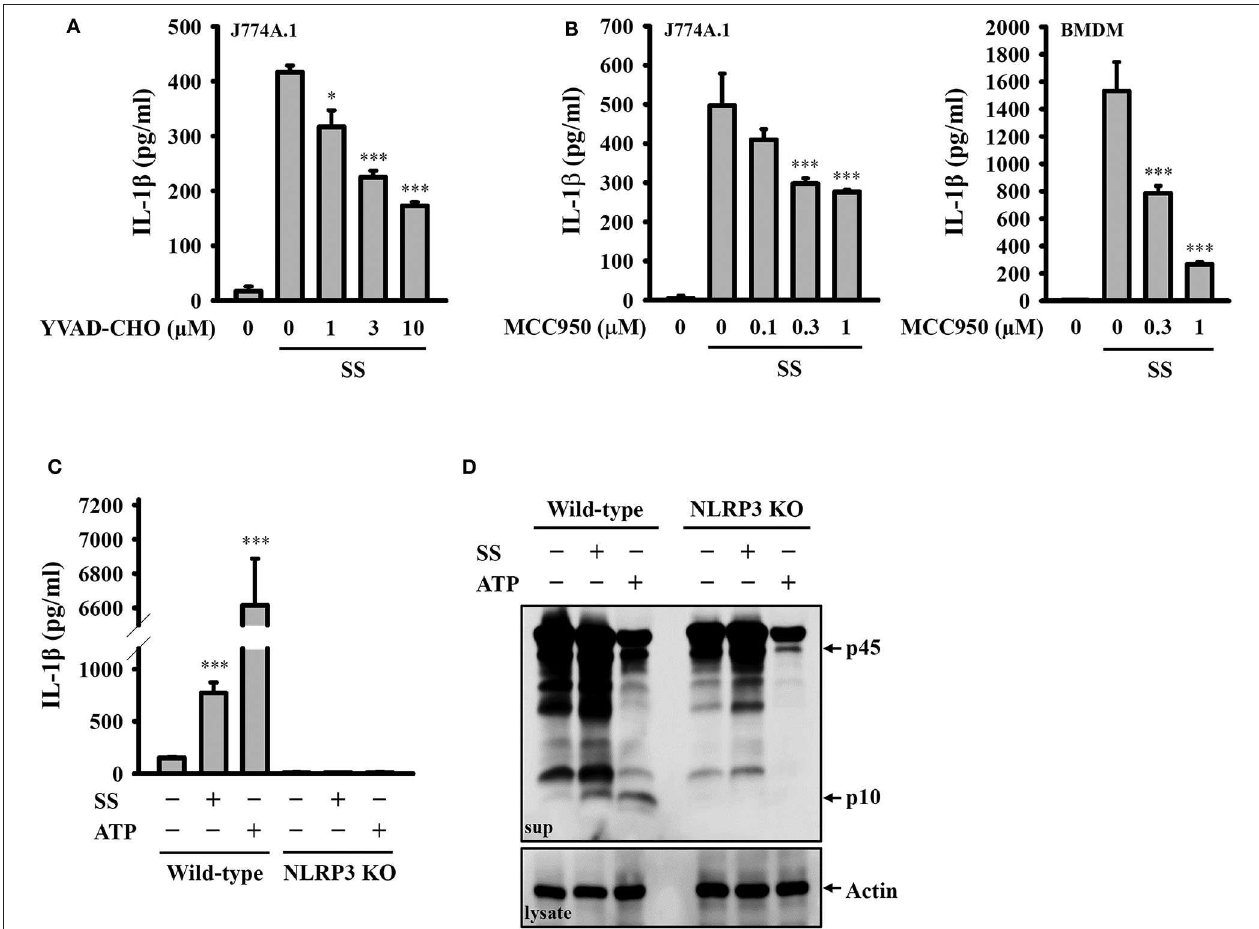
FIGURE 2 | S. sonnei induces IL-1 β secretion through the NLRP3 inflammasome. (A,B) J774A.1 macrophages or BMDM were primed with 1 µ g/ml LPS for 4h and then treated with YVAD-CHO (A) or MCC950 (B) for 0.5h. The cells were then infected with 50 MOI S. sonnei for an additional 20h. The levels of IL-1 β in the supernatants were measured by ELISA. (C,D) Wild-type or NLRP3 knockout J774A.1 macrophages were primed with 1 µ g/ml LPS for 4h and then infected with 50 MOI S. sonnei for an additional 20h. The levels of IL-1 β (C) and caspase-1 (D) in the supernatants were measured by ELISA and Western blotting, respectively. The ELISA data are expressed as the mean ± SD of four separate experiments. The Western blotting results are representative of three different experiments. * and *** indicate significant differences at the levels of p < 0.05 and p < 0.001, respectively, compared to S. sonnei -infected cells (A,B) or untreated control cells (C) (one-way ANOVA with Dunnett’s multiple comparisons